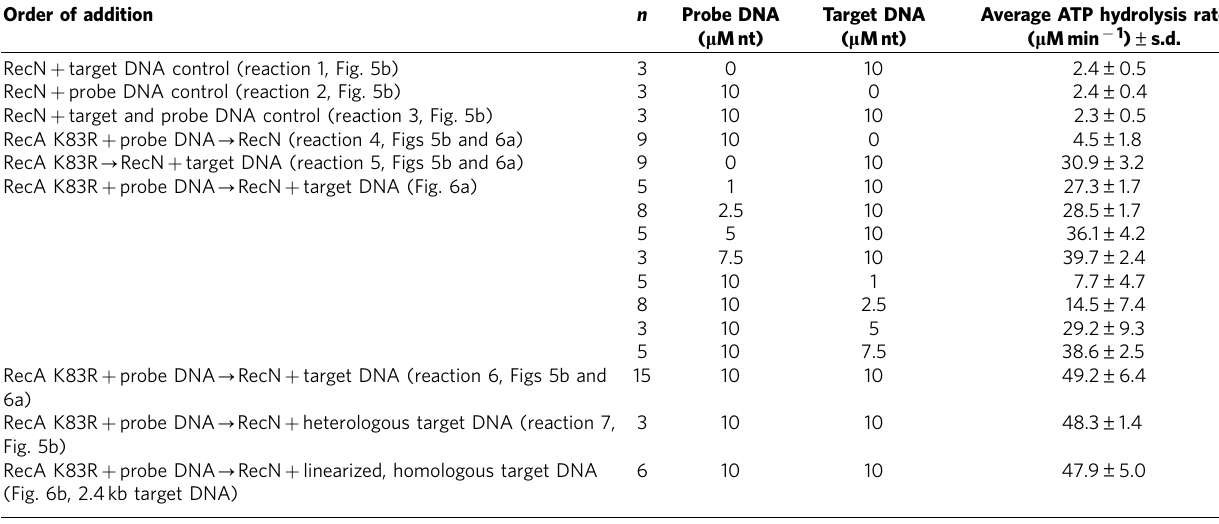
Reaction conditions are described in the legend to Fig. 5. Averages and s.d.’s were calculated from the number of independent trials indicated ( n ). Order of addition describes the experimental condition andtherelevantfigurecontainingrepresentativedata.TheprobeandtargetDNAsarederivedfrom2.4kbpplasmidDNAandaredescribedinthelegendtoFig.2.HeterologousDNAisnon-homologous, supercoiled RF1 f X174 DNA.